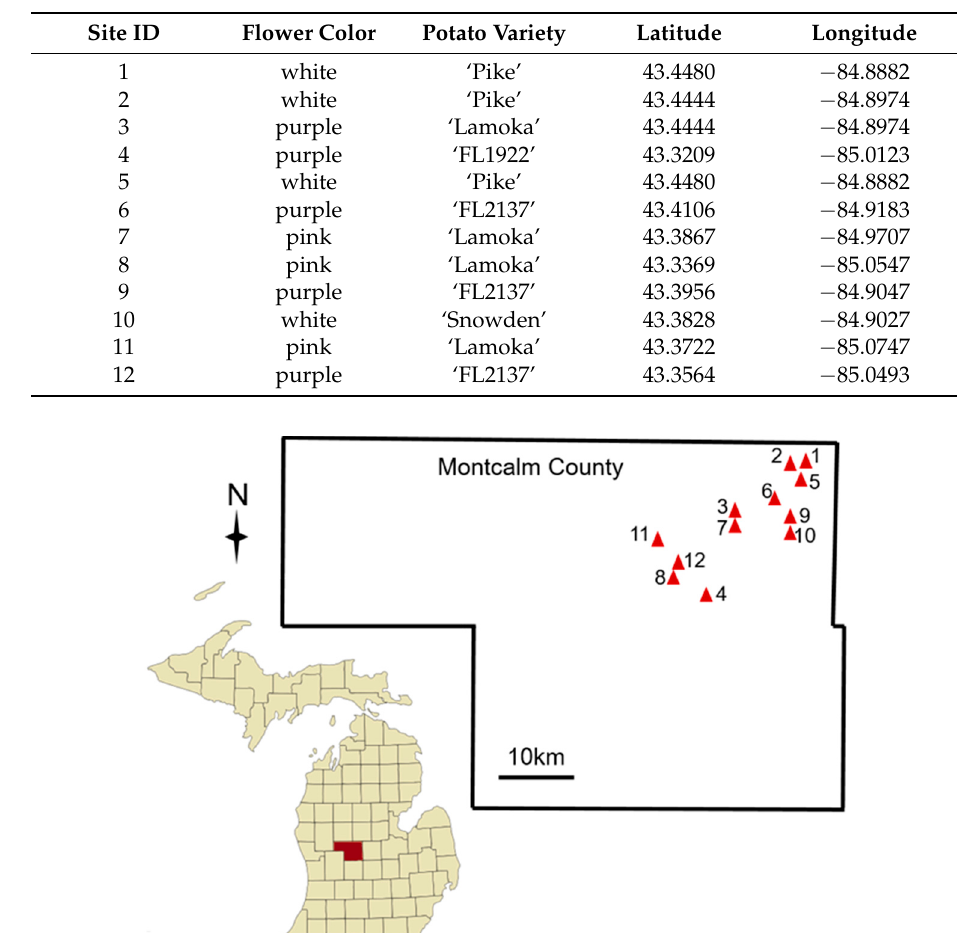
Table 1. Site descriptions of commercial potato fields used for bee surveys in 2016. Bees were surveyed with four white, yellow, and blue bowls and four blue vane traps at each site.